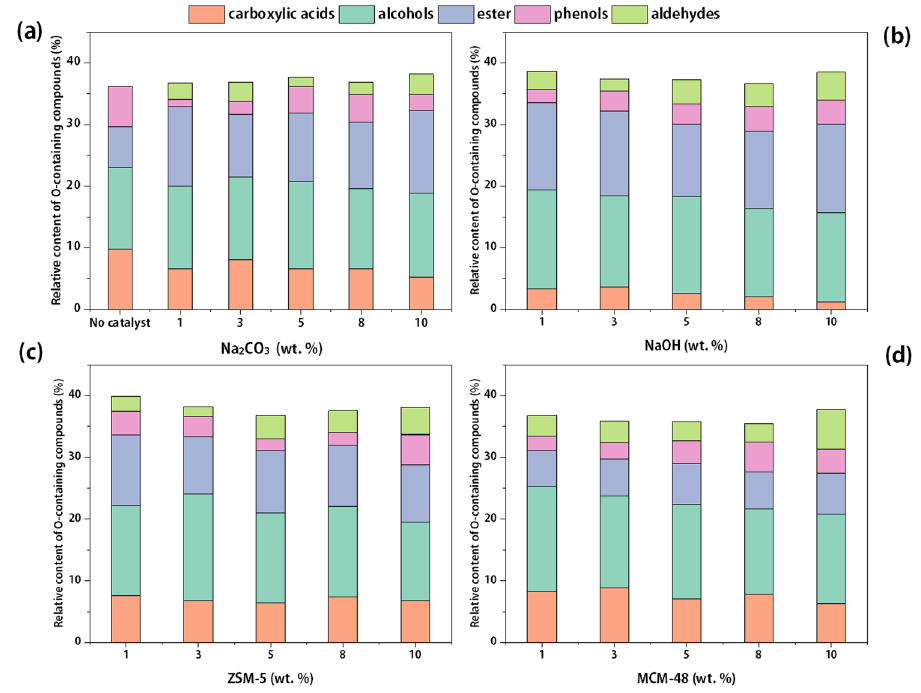
Figure 7. Oxygen-containing compound distribution of PR bio-oil: ( a ) Na 2 CO 3 , ( b ) NaOH, ( c ) ZSM-5, ( d ) MCM-48.